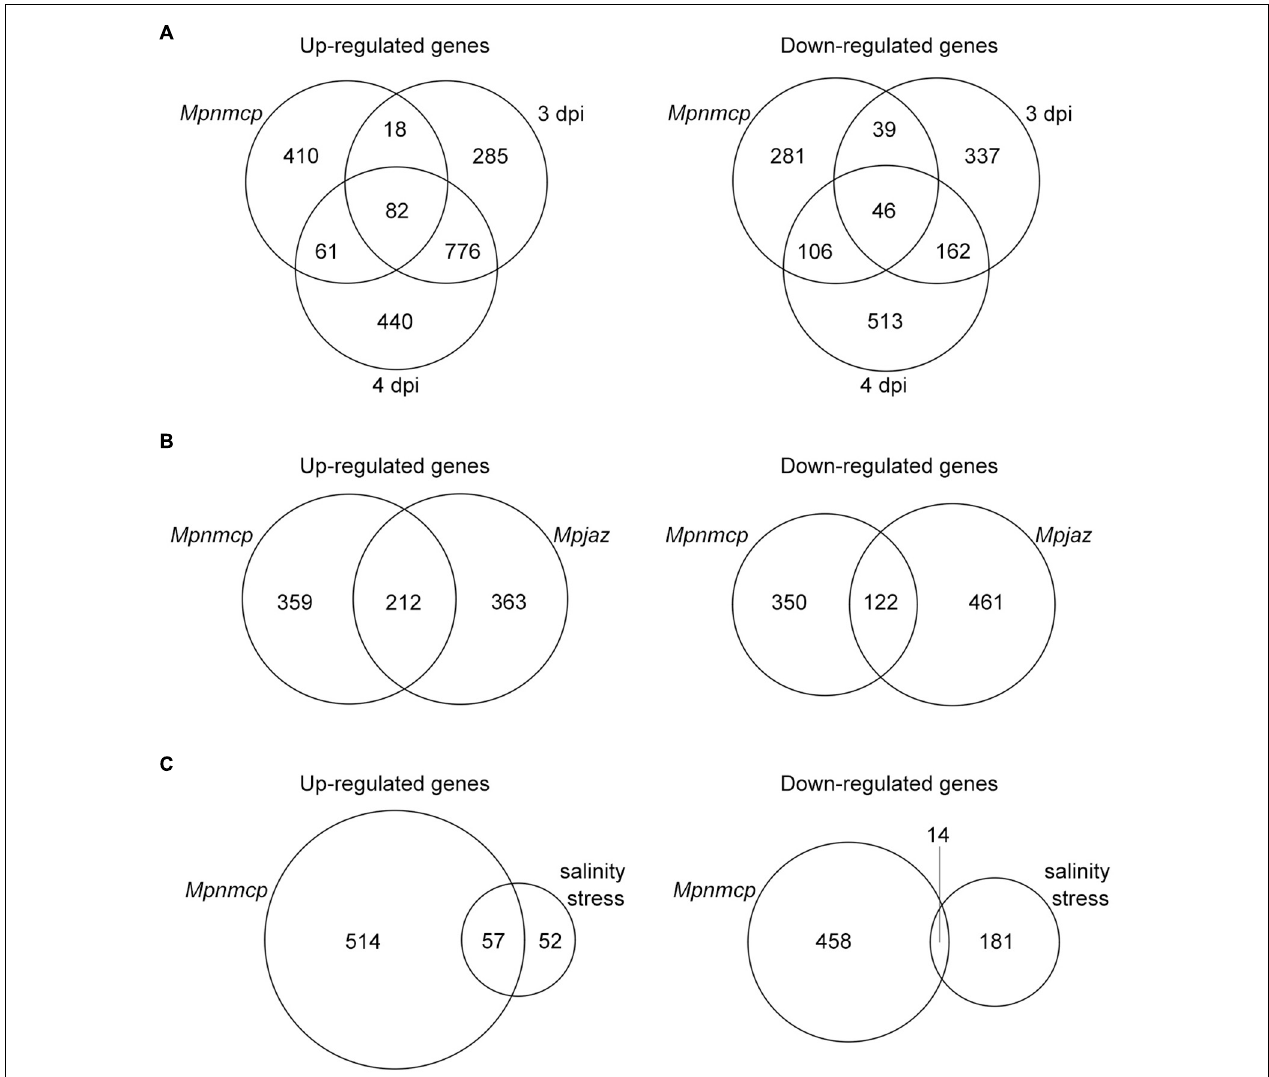
FIGURE 2 | Characteristics of differentially expressed genes (DEGs). (A) Venn diagram showing the overlap of DEGs among Mpnmcp , 3 dpi (days post inoculation with Phytophthora palmivora ) and 4 dpi. (B) Venn diagram showing the overlap of DEGs between Mpnmcp and Mpjaz . (C) Venn diagram showing the overlap of DEGs between Mpnmcp and Marchantia under salinity